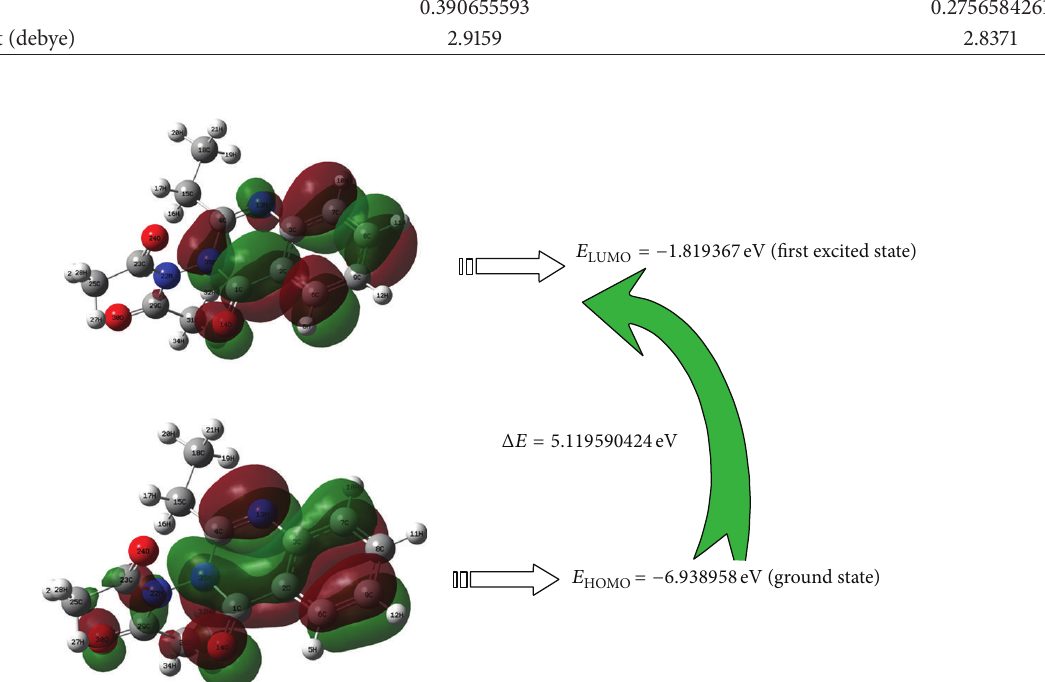
Figure 5: Calculated HOMO-LUMO plots of title compound 2